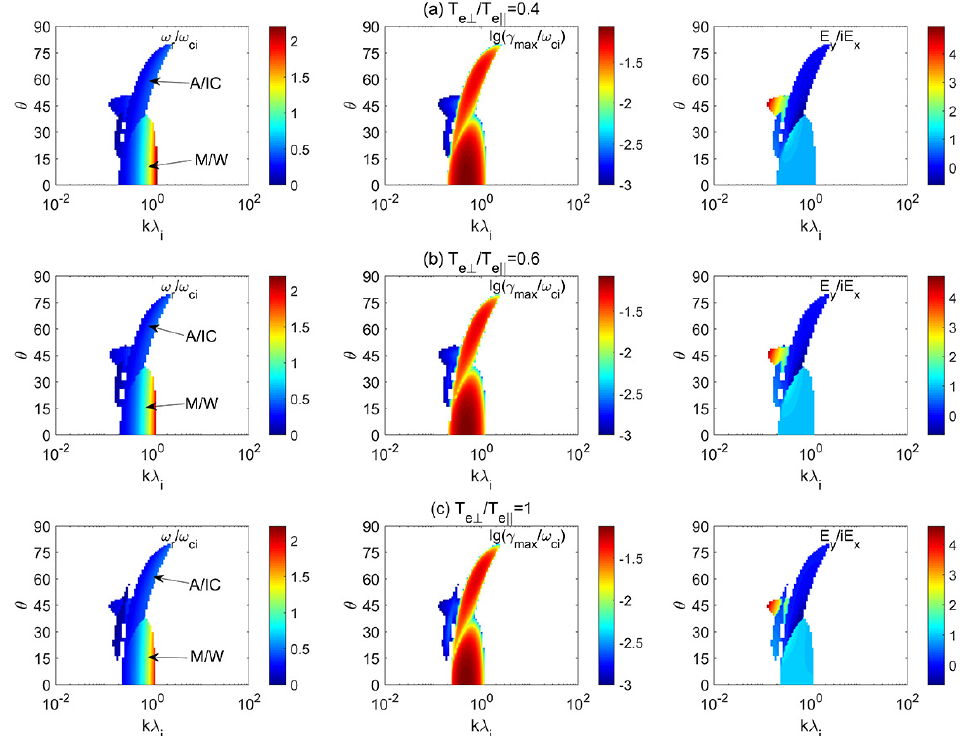
Figure 2. Color bar distributions of the real frequency ( ω r / ω ci ), maximum growth rate ( γ max / ω ci ), and polarization ( E y / iE x ) in the plane of the normalized wavelength ( k λ i ) and propagation angle ( θ ) for various electron temperature anisotropies: ( a ) T e ⊥ / T e (cid:107) = 0.4, ( b ) 0.6, and ( c ) 1 in a plasma with low beta β e (cid:107) = 0.2. The alpha beam drift velocity v α / v A = 2 was